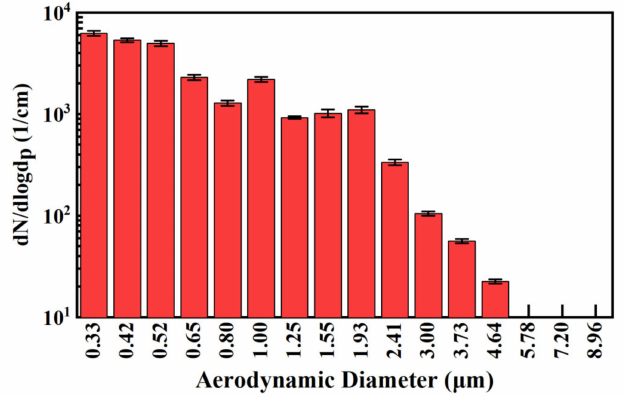
Figure 6. DOS oil concentration distribution (The number of experiments is 3).